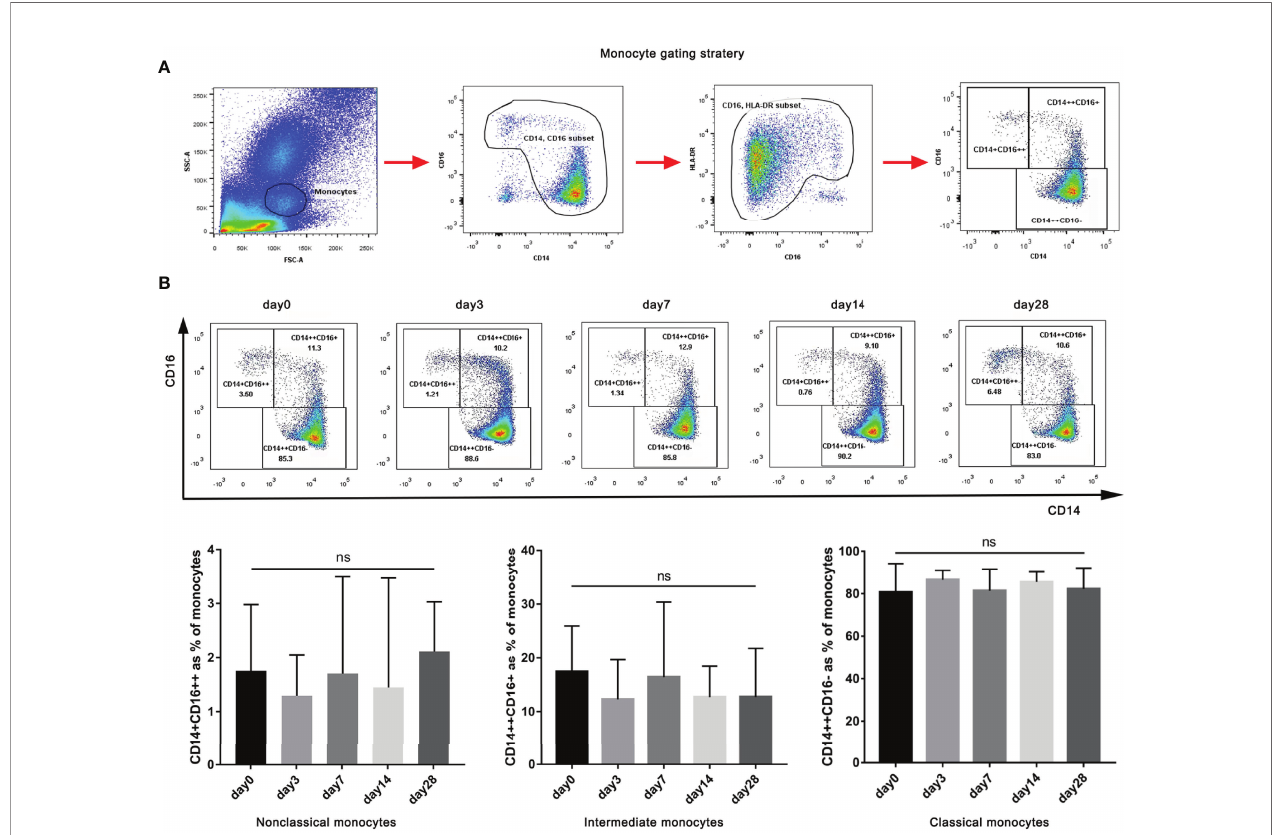
FIGURE 3 | Gating of monocytes and effect of G-CSF on monocyte subtypes in patients with HBV-ACLF. (A) Flow cytometry analysis and gating strategy used to determine monocytes and their subsets. (B) Effect of G-CSF on monocyte subtypes in patients with HBV-ACLF (n=12). Non-parametric (Wilcoxon ’ s matched-pair test) statistical analysis was used. Data presented as median with interquartile range. ns represents P > 0.05; G-CSF, Granulocyte-colony stimulating factor; HBV- ACLF, hepatitis B virus-related acute-on -chronic liver